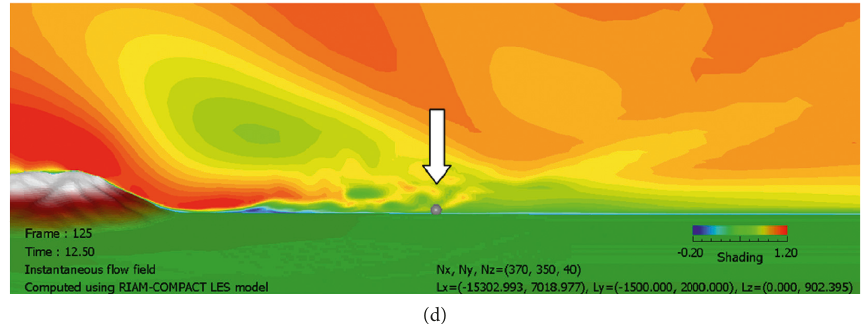
Figure 16: Result of the computational simulation of wind conditions of stably stratified flow targeting the actual complex